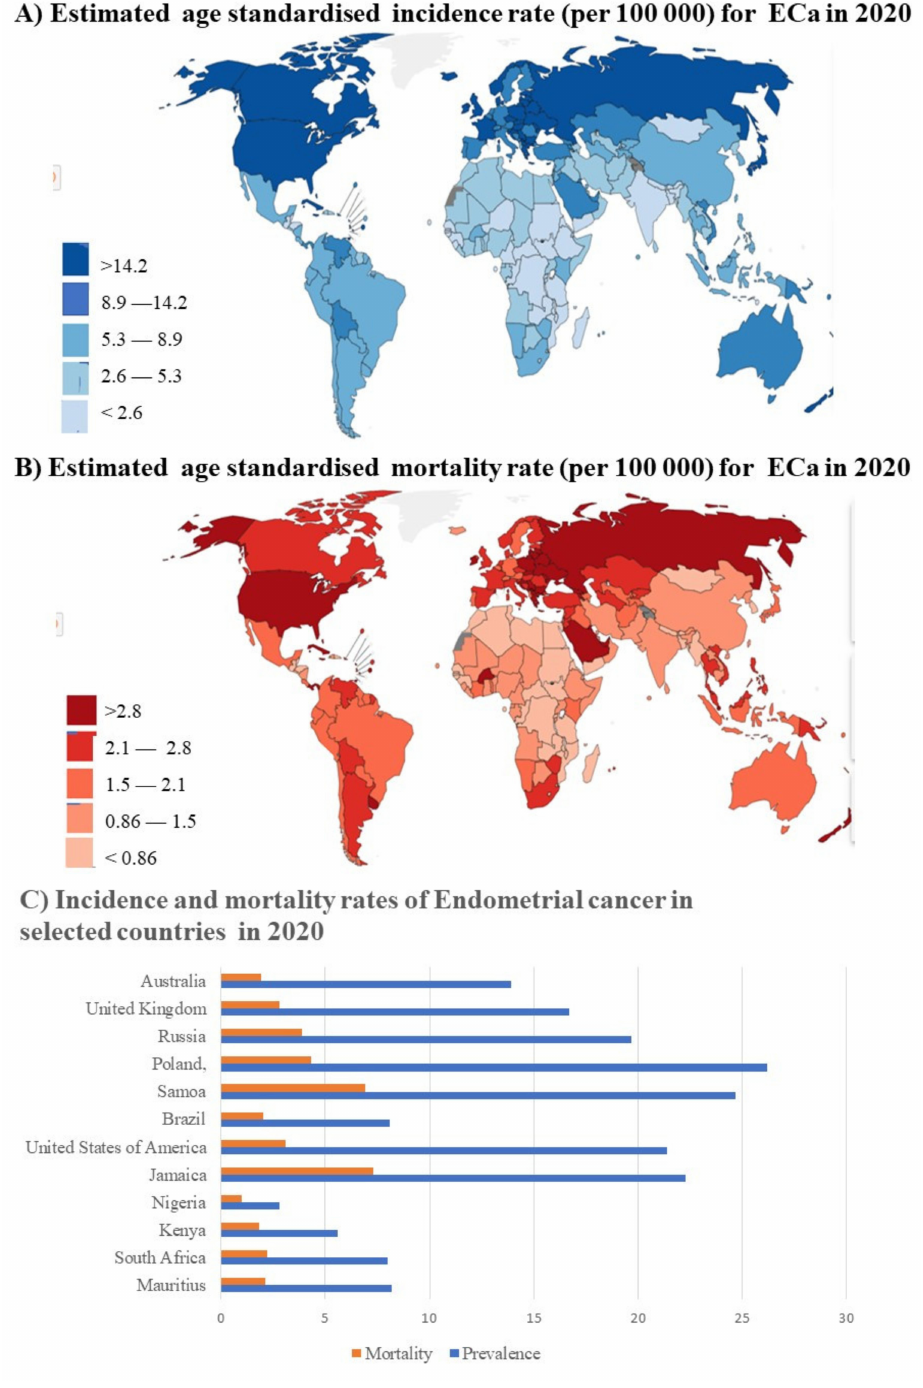
Figure 2. GLOBOCAN incidence and mortality statistics for Endometrial cancer: ( A ) world map representing the worldwide age standardized incidence rates of endometrial cancer. The highest rates are observed to be in North America, Eurasia, Australia and New Zealand; ( B ) world map representing the worldwide age standardized mortality rates of endometrial cancer. The highest mortality rates are in North America and Eurasia, mirroring the incidence rates and Australia and New Zealand; ( C ) a graph comparing the incidence and mortality rates of endometrial cancers in specific countries demonstrating various trends. All data fall within the 95% confidence interval